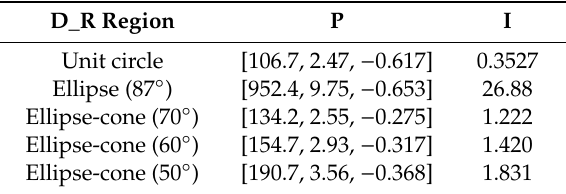
Table 1. State feedback PI controller parameters designed using Equation (8) for the considered D R regions. D_R Region P I Unit circle [106.7, 2.47, − 0.617] 0.3527 Ellipse (87 ◦ ) [952.4, 9.75, − 0.653] 26.88 Ellipse-cone (70 ◦ ) [134.2, 2.55, −